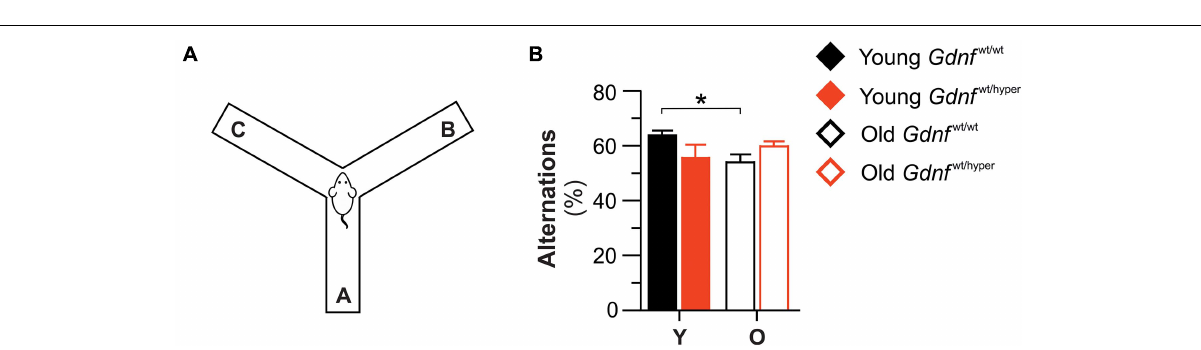
FIGURE 6 | Gdnf wt / hyper mice resist age-related decline in Y-maze test. (A) The spatial recognition memory of Gdnf wt / wt and Gdnf wt / hyper mice was assessed with the Y-maze test. (B) Upon aging, the number of alternations was significantly decreased in Gdnf wt / wt mice, but not in Gdnf wt / hyper animals. n = 7 (young Gdnf wt / wt ), n = 5 (old Gdnf wt / wt ), n = 6 (young Gdnf wt / hyper ), n = 12 (old Gdnf wt / hyper ). Data are presented as mean ± SEM. * p < 0.05. O, old; Y,